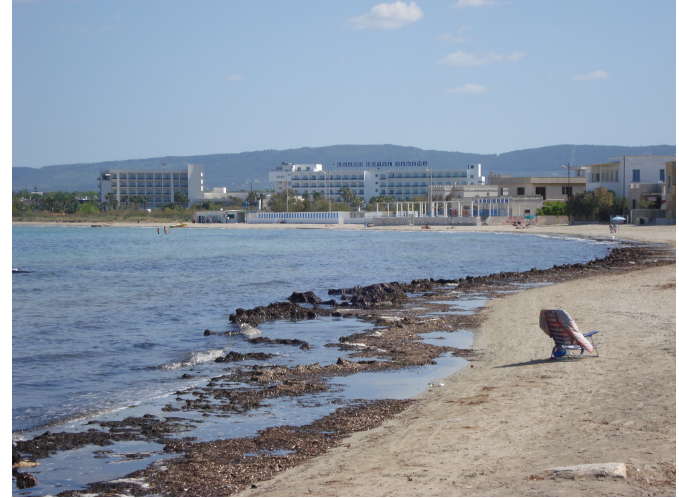
Figure 8. Organic deposits of Posidonia oceanica along the coastline during SAR